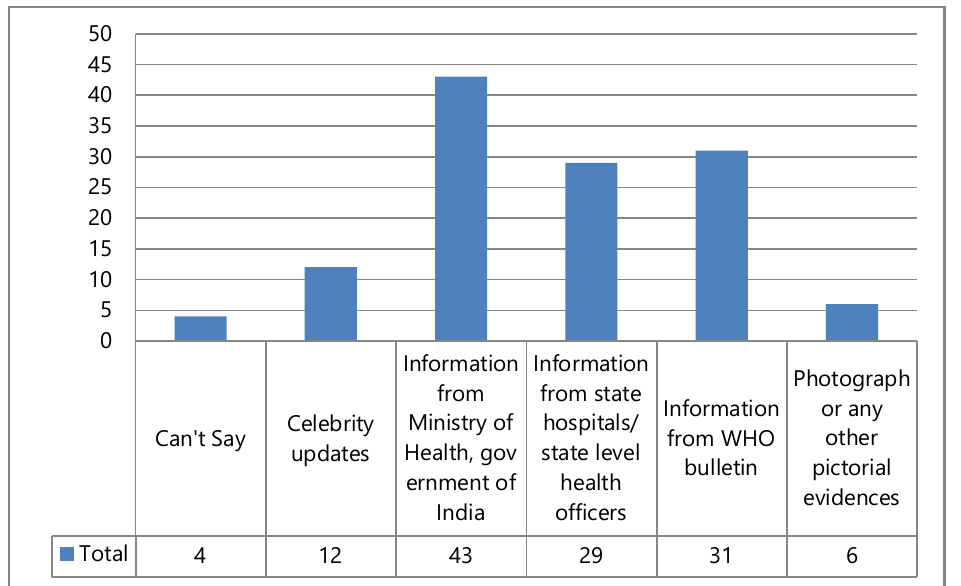
Graphic 3: Source of Information Mostly Preferred or Followed While Using Twitter (Source: Online